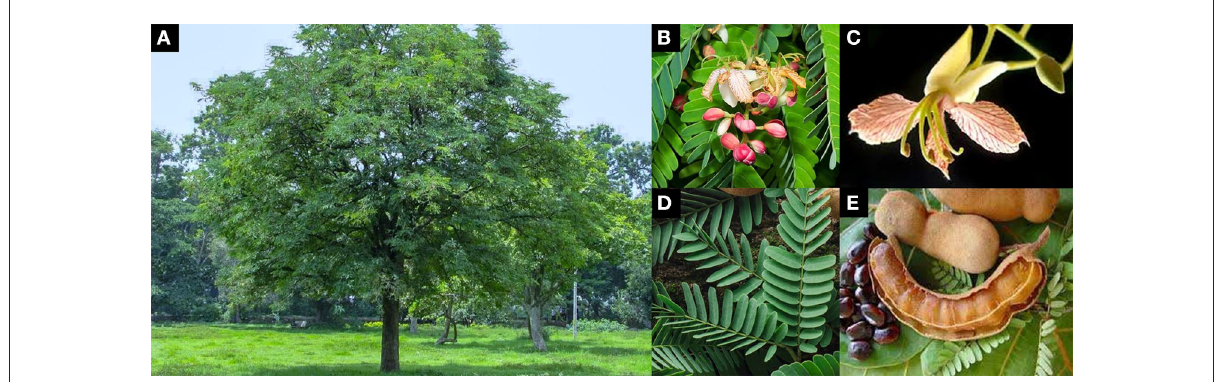
FIGURE3 Characteristics of T. indica (A) habit (B) inflorescence (C) floret (D) leaves (E) ripe fruits and seeds [adapted from